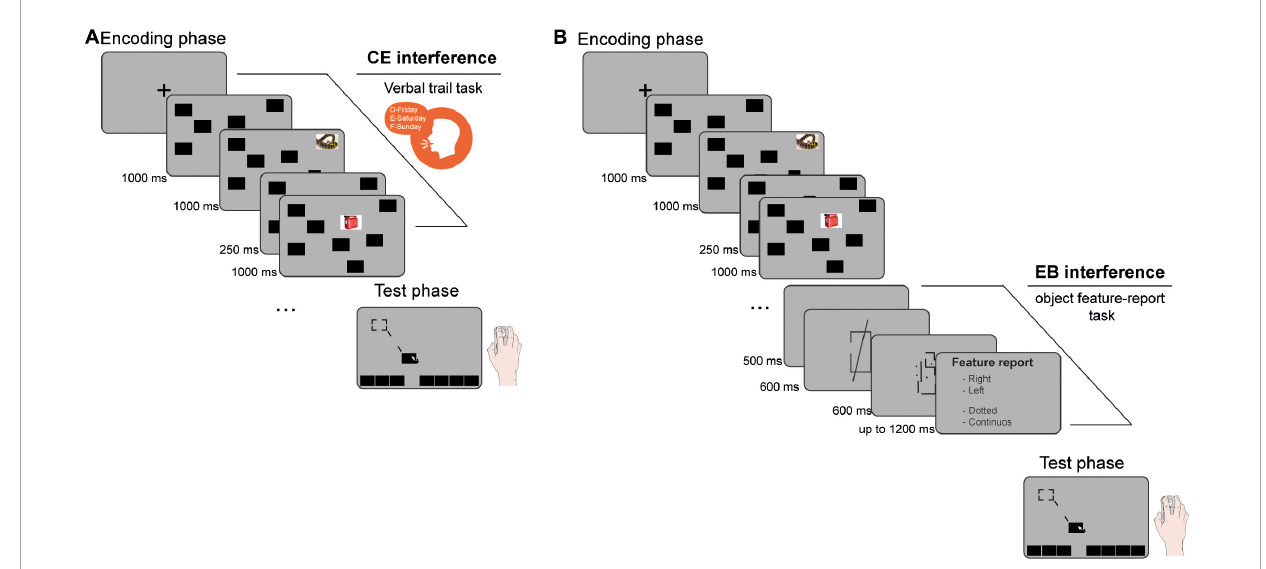
FIGURE1 Schematic representations of the experimental procedures. (A) In Experiment 1 and 2 the concurrent administration of a verbal-trail task during the encoding phase of the emotional object relocation task (EORT) was used to interfere with the central executive (CE). (B) In Experiment 3, an object feature report-task immediately after the encoding phase of the EORT was used to interfere with the episodic buffer (EB).